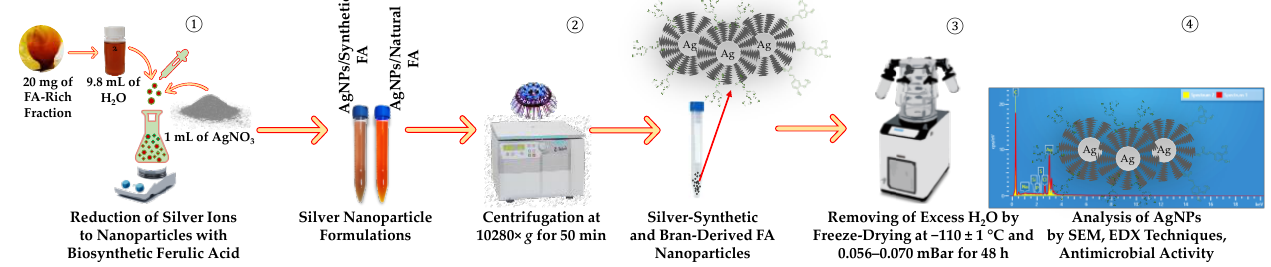
Figure 2. A schematic representation of major steps undertaken for the preparation of silver nanoparticles following the green synthesis principle using rye bran-derived trans -ferulic acid recovered by enzymatic hydrolysis with cellulose-degrading enzyme Viscozyme L.